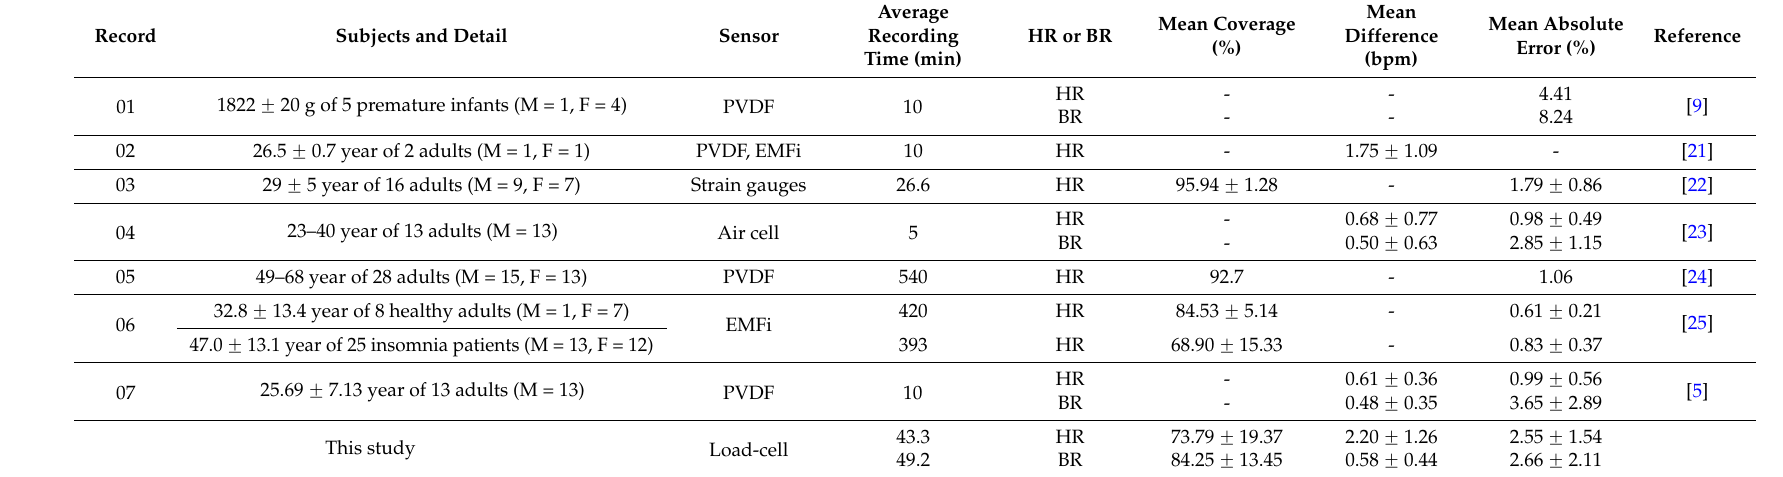
Table 7. Performance summary of other related